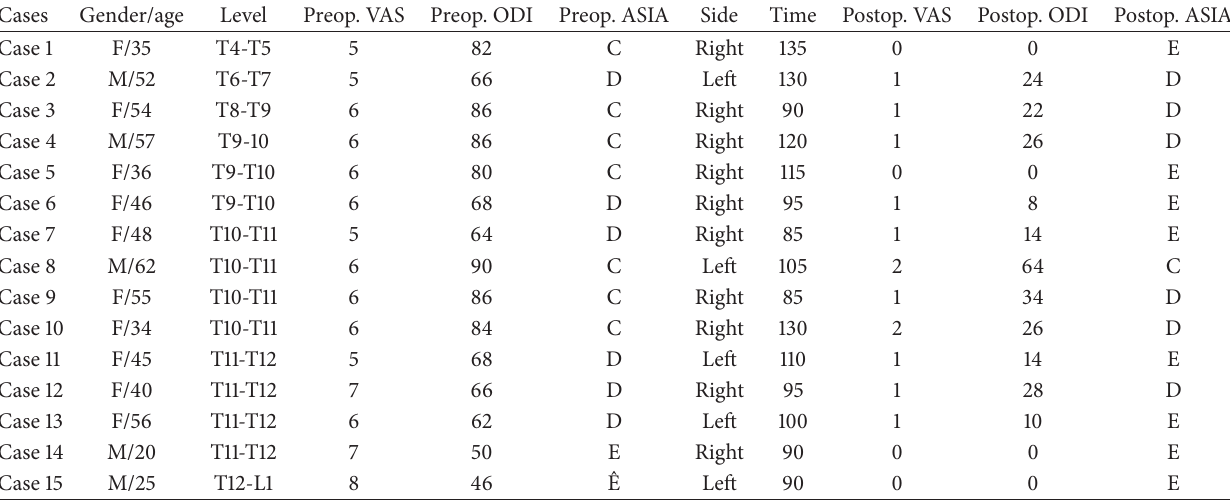
Table 1: Preoperative and postoperative features of the